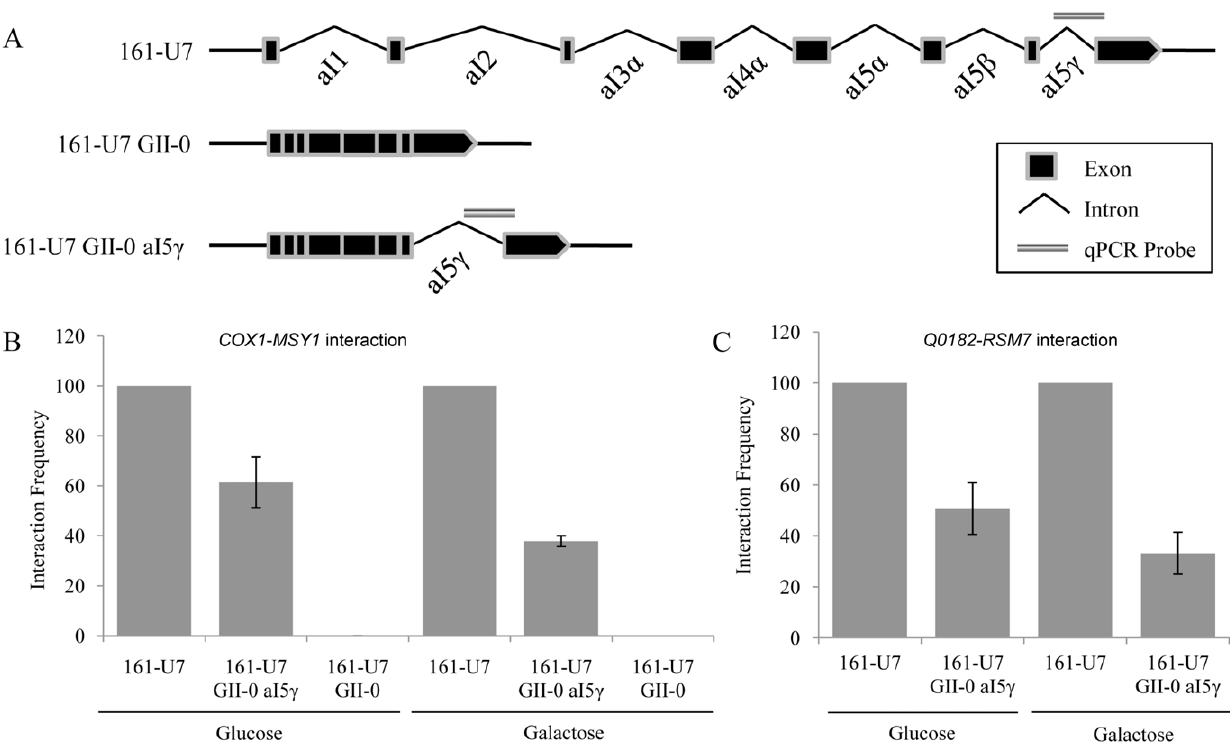
Figure 4. Mito-nDNA interactions require active mitochondrial reverse transcriptase machinery. A) Illustration of COX1 gene arrangement in the WT (161-U7), intron a15 c (161-U7 GII-0 a15 c ), and no mitochondrial group II introns (161-U7 GII-0) strains. Group II introns within the COX1 gene encode functional reverse transcriptase. The region of COX1 that participates in the COX1 - MSY1 interaction is indicated (qPCR probe). Strain 161-U7 GII-0 was included as a control to rule out a nuclear sequence, originating from a mitochondrial integration within the nuclear genome (NUMT), being responsible for the observed interaction. B) COX1-MSY1 interaction frequencies for wt and intron mutants, illustrated in A), grown in glucose or galactose. C) Q0182 - RSM7 interaction frequencies for mitochondrial reverse transcriptase mutant 161-U7 GII-0 a15 c , illustrated in A), grown in glucose or galactose. Interaction frequencies are expressed as percentages of the wild-type S. cerevisiae strain 161-U7 for each carbon source (set at 100%) + / 2 standard error of the mean (n=3). Interaction values in B) and C) were corrected for nuclear genome copy number to facilitate direct comparison.